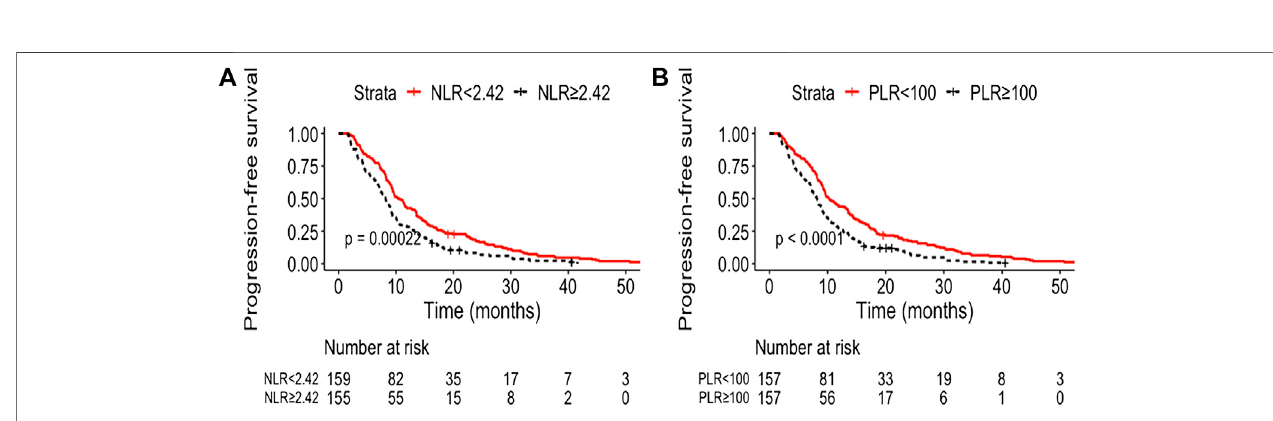
FIGURE2| Kaplan – Meiercurvesofdifferentgroupanalysesofprogression-freesurvival(PFS)accordingtopatients ’ NLRandPLRlevel. (A) PatientswithlowNLR vs. high NLR at baseline; (B) patients with low PLR vs. high PLR at